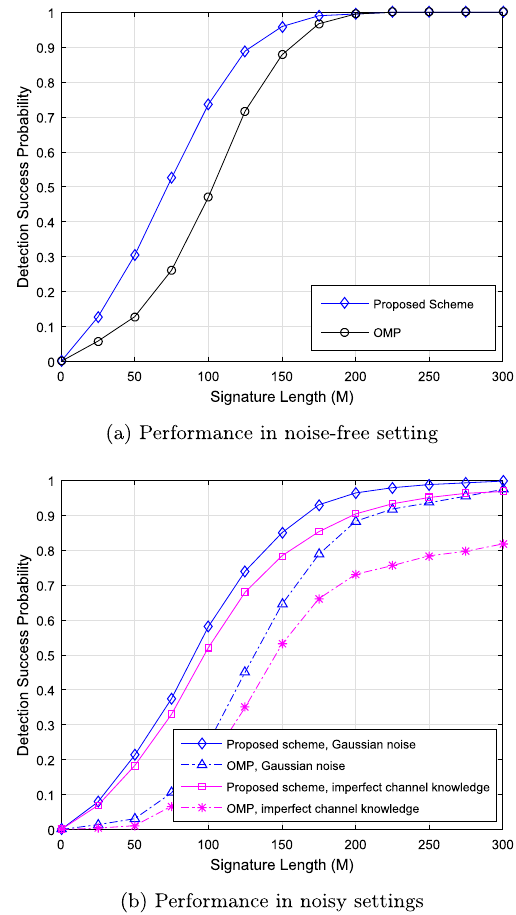
Fig. 4 Robustness of the proposed scheme compared with standard